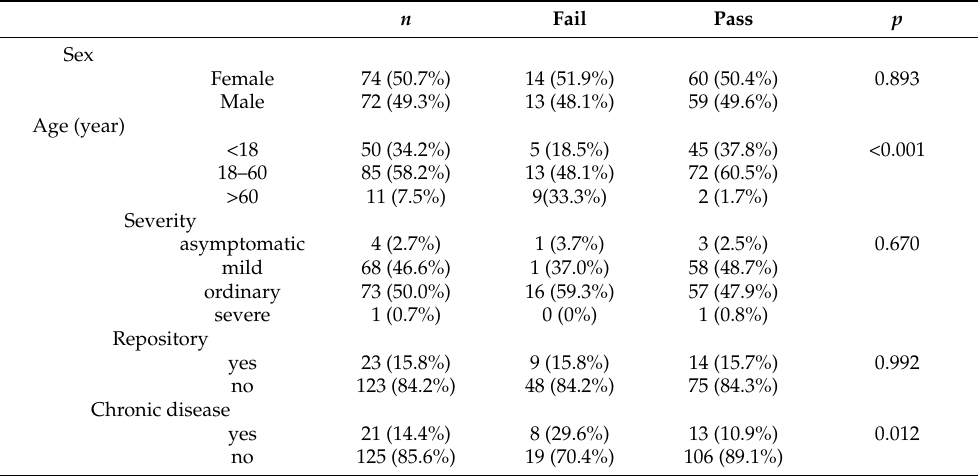
Table 1. Comparison of characteristics data between the PASS group and the FAIL group.